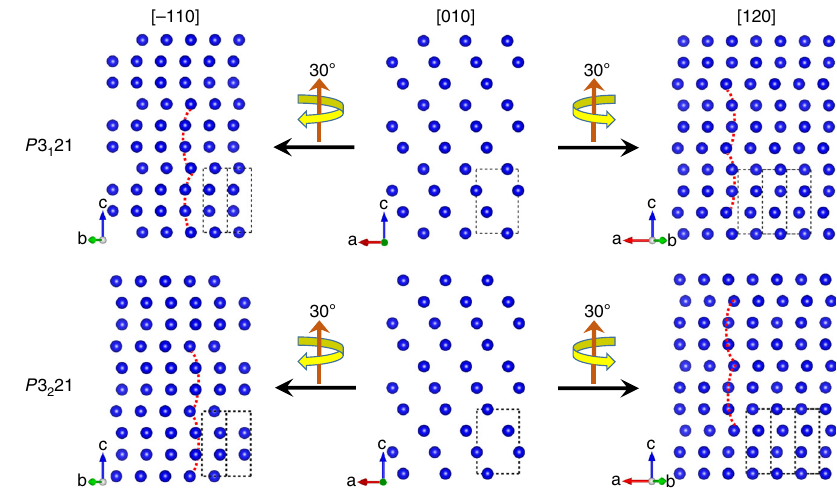
Fig. 2 A tilt-series of Te structural models with P 3 1 21 and P 3 2 21 space groups. Projections of Te crystal structural models with right-/left-handedness along different orientations in a tilt series.